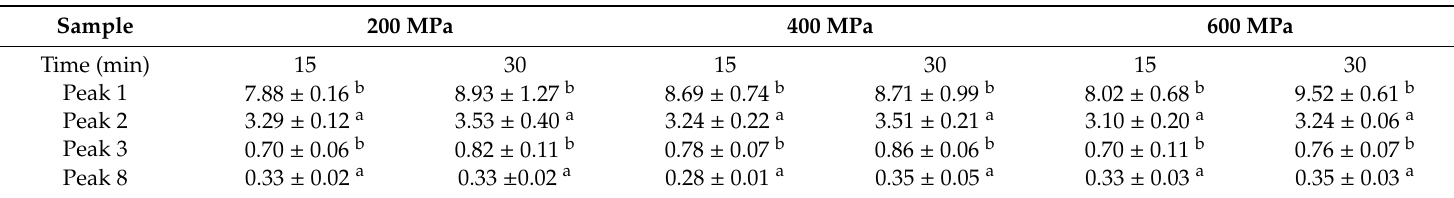
Table 2. HPLC-RID analysis of water-soluble carbohydrates released from apple by-product after HHP treatment non-assisted by Celluclast ® .